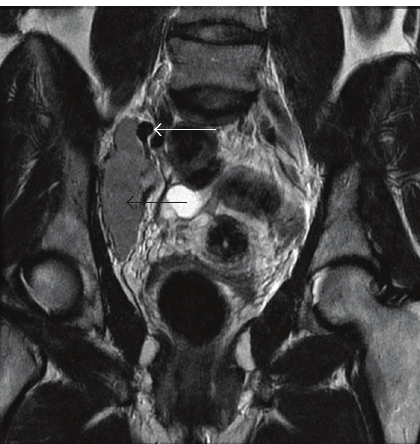
Figure 1: Pelvic magnetic resonance imaging: coronal T2-weighted imaging shows a well-capsulated, hyperintense, solid mass (black arrow), next to the iliac vessels (white arrow).